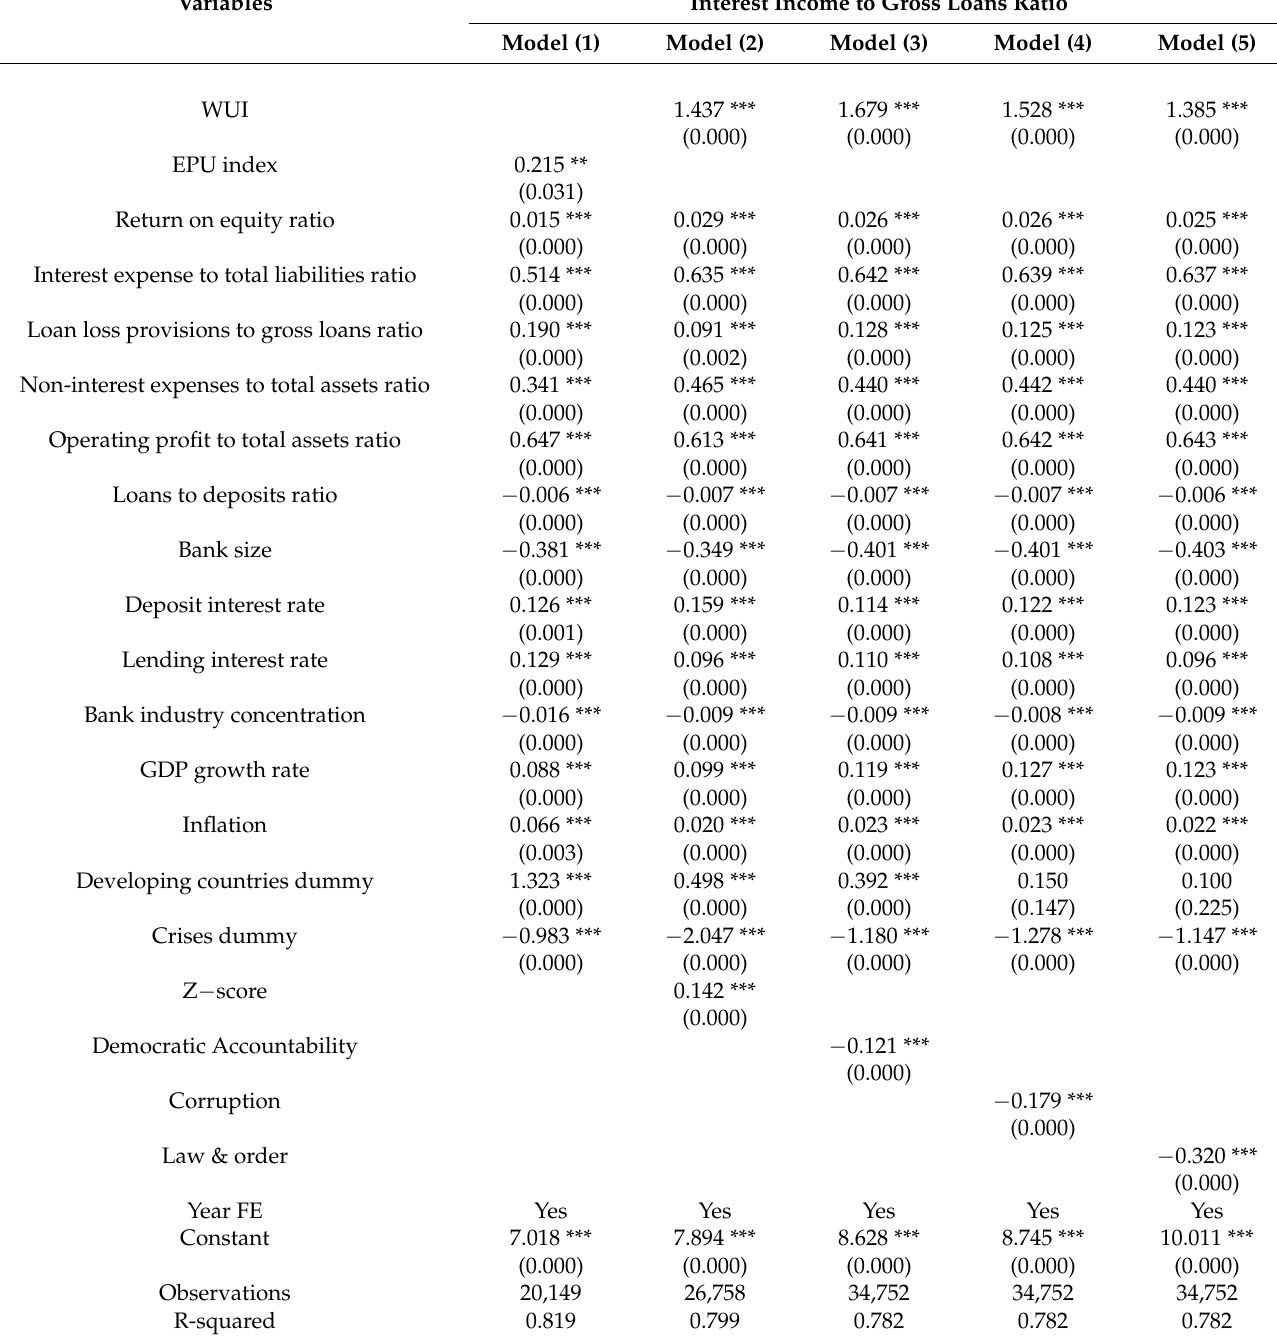
Table 6. Economic and political uncertainty and bank loan pricing: Robustness checks with additional controls. This table reports results of robustness checks regarding the impact of policy uncertainty on bank loan interest rates. Bank loan interest rate is measured with annual ‘interest income to gross loans ratio’ and is the dependent variable in all models. WUI is world uncertainty index of Ahir et al. (2018), which represents economic uncertainty. EPU index is the economic policy uncertainty index of Baker et al. (2016). Others are control variables. Detailed definitions of variables are given in Table 2. The results are estimated with pooled OLS estimator using heteroskedasticity robust standard errors. P -values are given in parenthesis. *** and ** represent statistical significance at 1% and 5% levels,